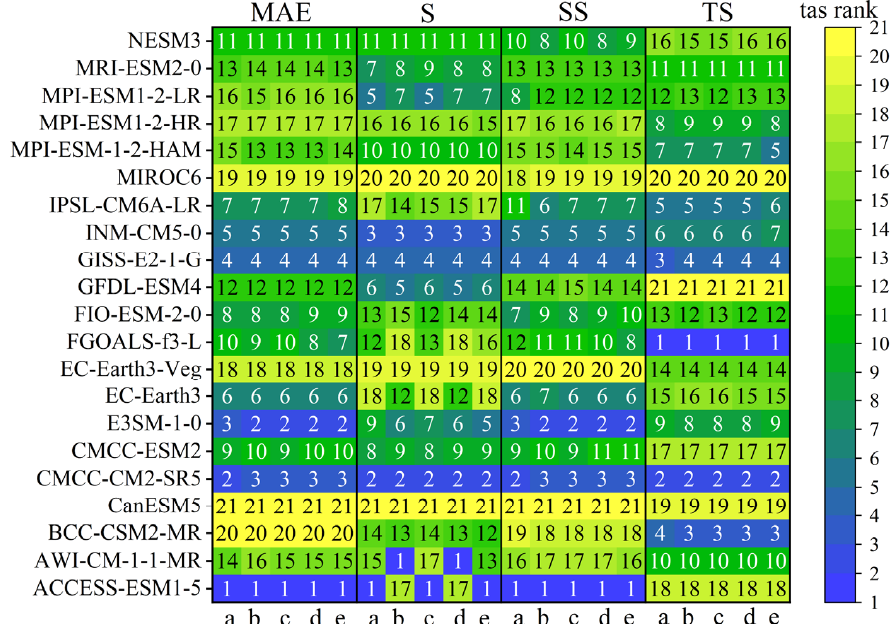
Figure 3. Fitting performance ranking of 21 climate models simulating tas monthly series of the Yellow River Basin from 1995 to 2014 under different interpolation methods and evaluation metrics. a, b, c, d, and e under each evaluation method are the evaluation rankings of the five interpolation methods: BI, IDW, kriging, NNI, and spline, respectively. The higher the ranking, the higher the model’s fitting accuracy.